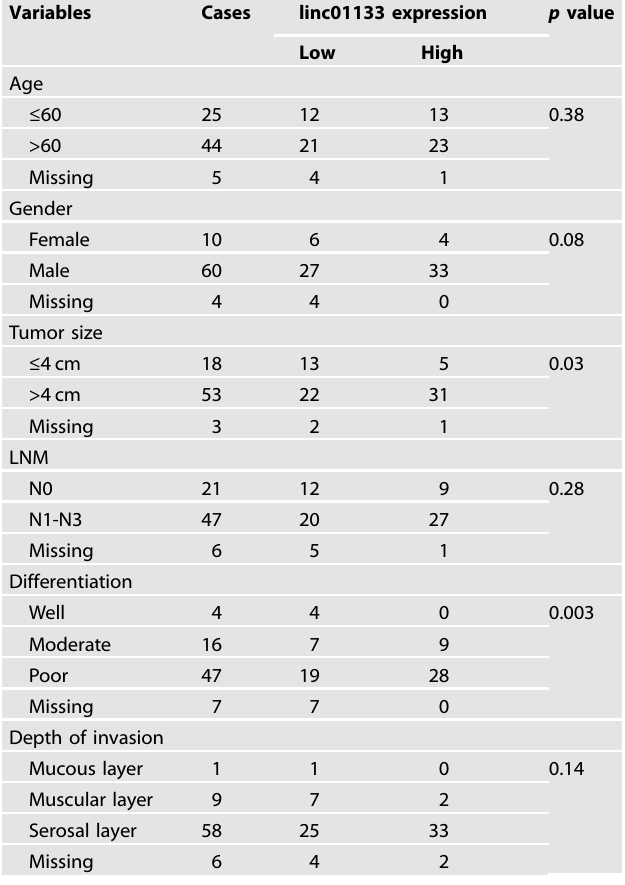
Table 1. Association between linc01133 expression and clinicopathologic characteristics in gastric cancer